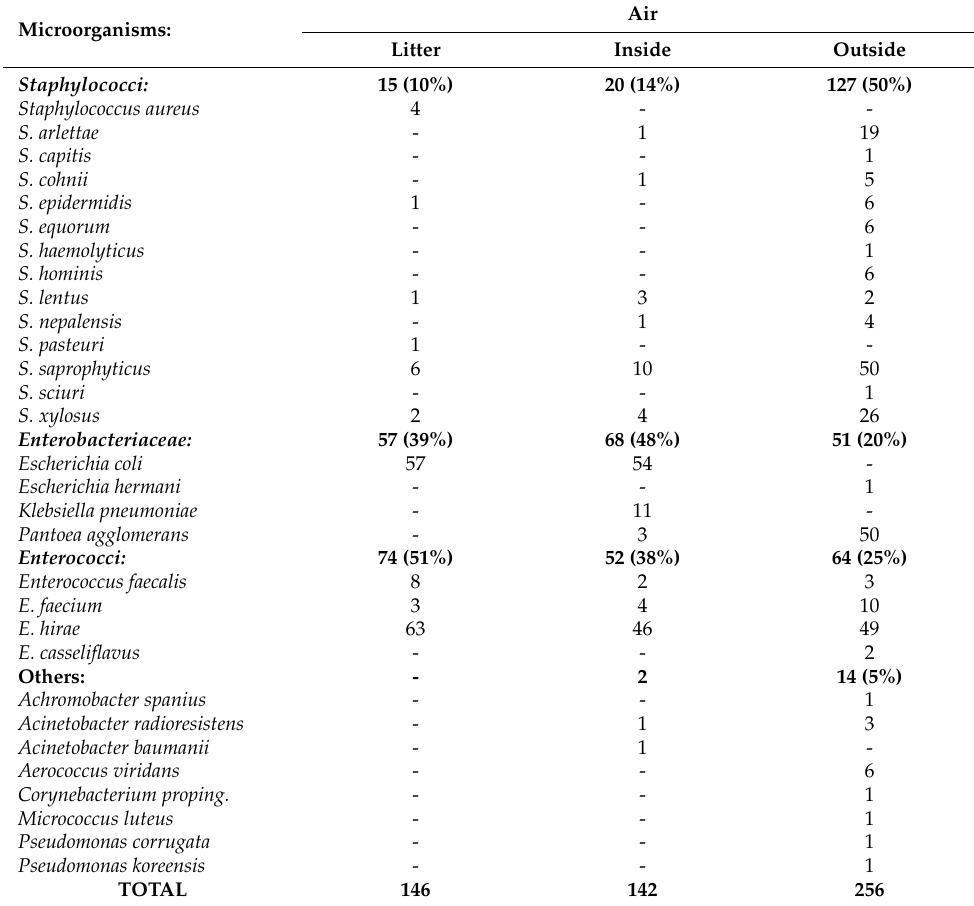
Table 2. Distribution of isolates identified in litter and in the inside and outside air of the sampled broiler farm (the percentage of each bacterial group over the total of each type of sample is indicated in parentheses).